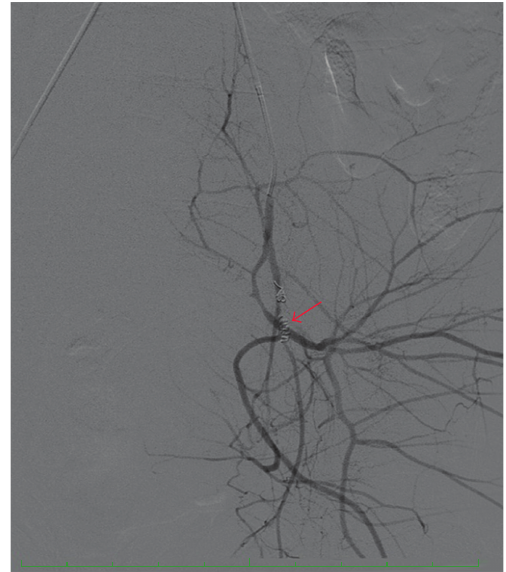
Figure 3: Postembolization angiography of the anterior division of the left internal iliac artery illustrates the embolization coils (arrow). There is no evidence of a pseudoaneurysm or of contrast extravasation.